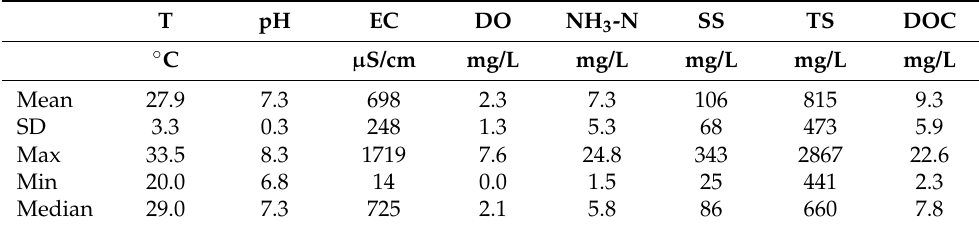
Table 1. Water quality parameters of samples.